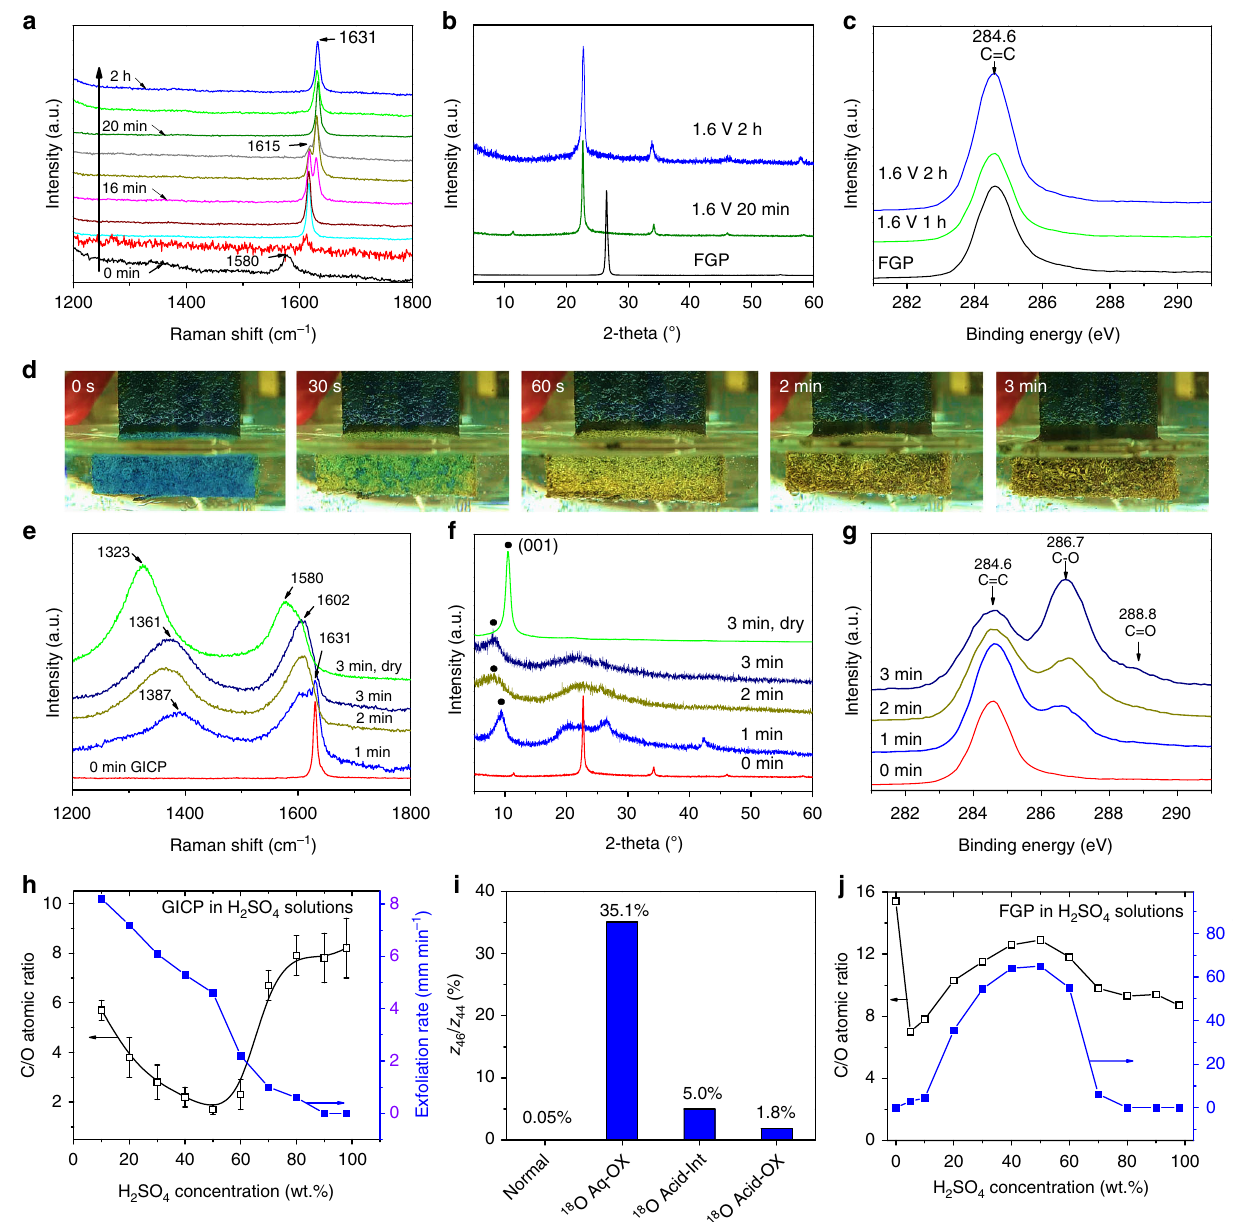
Fig. 3 Investigation on the EC synthesis process of EGO. a-c , Step I: EC intercalation. Raman spectra ( a ), XRD patterns ( b ), and XPS C1s spectra ( c ) after intercalation for different time. From bottom to top in ( a ), the reaction time is 0, 1, 4, 10, 16, 17, 18, 20, 60, and 120 min in sequence. d-g , Step II: EC oxidation. d , Morphology and color change of a GICP slice with reaction time. Raman spectra ( e ), XRD patterns ( f ), and XPS C1s spectra ( g ) after reaction for different time. The Raman spectra and XRD patterns indicated by 0, 1, 2, and 3 min in ( e ) and ( f ) were taken from the as-synthesized GICP and EGO samples after 1, 2, and 3 min reaction, respectively, without cleaning and drying, and those indicated by 3 min, dry were taken from the samples obtained after 3 min reaction followed by cleaning and drying. It can be found that the contained water and H 2 SO 4 have signi fi cant in fl uences on the Raman spectra and XRD patterns (also see Supplementary Note 4 and Supplementary Fig. 9). The XPS C1s spectra in ( g ) were taken from the samples after cleaning and drying. h , C/O atomic ratio of the exfoliated product and the corresponding exfoliation rate of GICP in H 2 SO 4 solutions with different concentrations. The error bar shows the range of C/O atomic ratio measured from fi ve samples in each batch of product. i , Comparison of 18 O content in the EGO samples synthesized by four different combinations of the normal and 18 O-containing reagents, including H 2 SO 4 for EC intercalation (normal Acid-Int/ 18 O Acid- Int), and water (normal Aq-OX/ 18 O Aq-OX) and H 2 SO 4 (normal Acid-OX/ 18 O Acid-OX) used in EC oxidation process. Normal: EGO synthesized with normal Acid-Int, Aq-OX, and Acid-OX; 18 O Aq-OX: EGO synthesized with normal Acid-Int, 18 O Aq-OX, and normal Acid-OX; 18 O Acid-Int: EGO synthesized with 18 O Acid-Int, normal Aq-OX, and normal Acid-OX; 18 O Acid-OX: EGO synthesized with normal Acid-Int, normal Aq-OX, and 18 O Acid- OX. ( j ), C/O atomic ratio of the exfoliated product and the corresponding exfoliation rate of FGP in H 2 SO 4 solutions with different